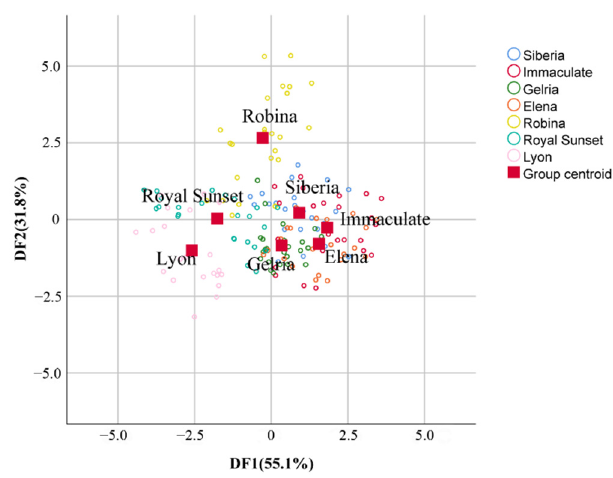
Figure 8. The first two discriminant function (DF) gradients were obtained by canonical discriminant analysis using the physiological indices of seven lily varieties from 0 to 35 days.